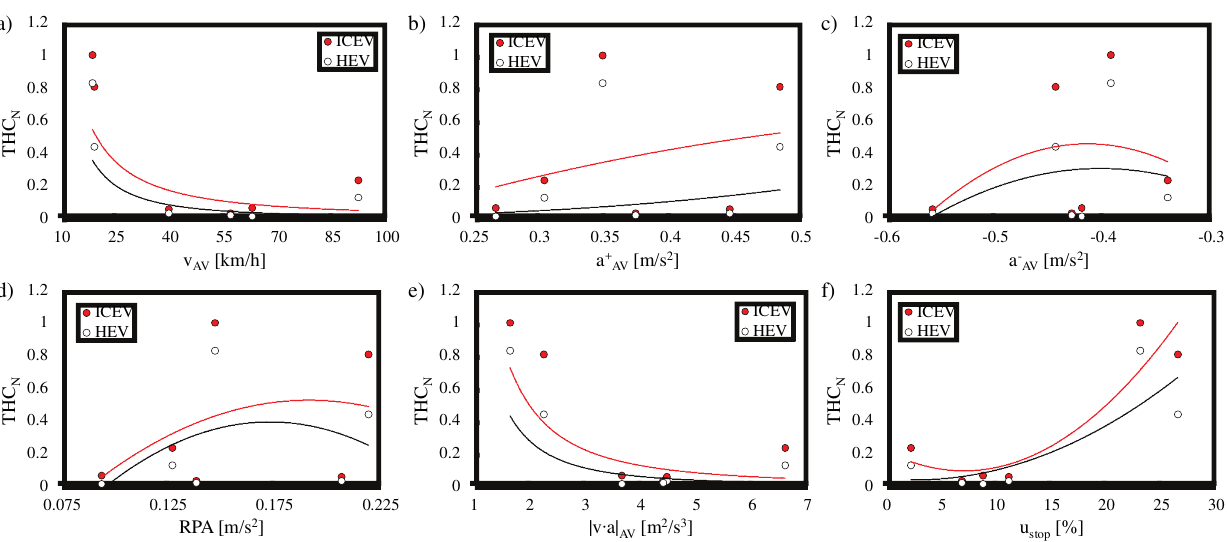
Fig. 2. The dependence of normalized road emission of hydrocarbons on driving pattern parameters: average speed (a), average acceleration (b), average deceleration (c), relative positive acceleration (d), average absolute value of the product of speed and acceleration (e), time share of vehicle stop (f)